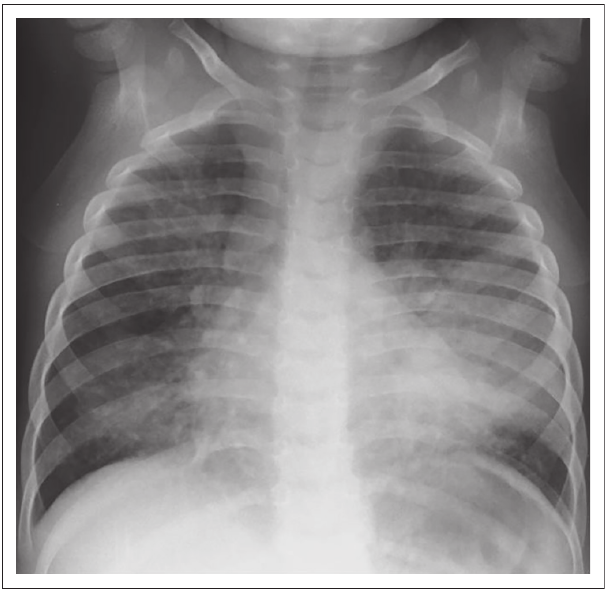
FIGURE 7: 3-year-old boy with known LIP who presented with worsening respiratory distress. Frontal chest radiograph shows bilateral reticulo-nodular pattern opacities with areas of confluent opacifications particularly in the lingual and left lower lobe.